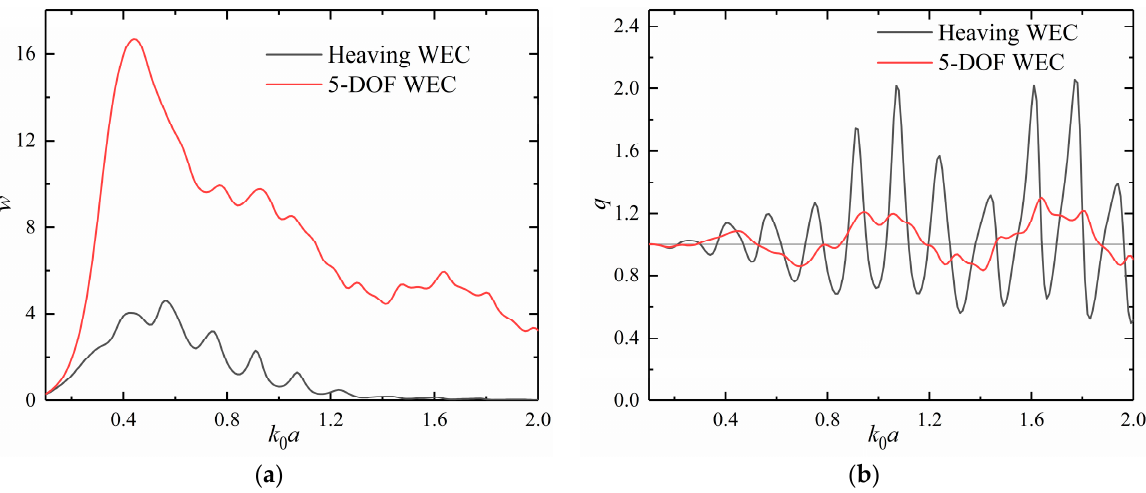
Figure 10. The performance of an array composed of five WECs: ( a ) capture width; ( b ) interaction factor. Heaving WEC: each WEC moves and extracts power in heave mode only; 5 ‐ DOF WEC: each WEC moves and extracts power in five degrees of freedom.